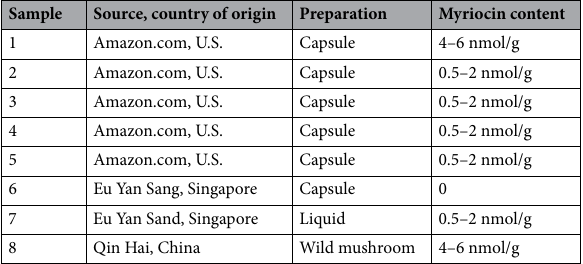
Table 1. Table depicting the source, formulation and myriocin content in various Cordyceps extracts screened in this study.